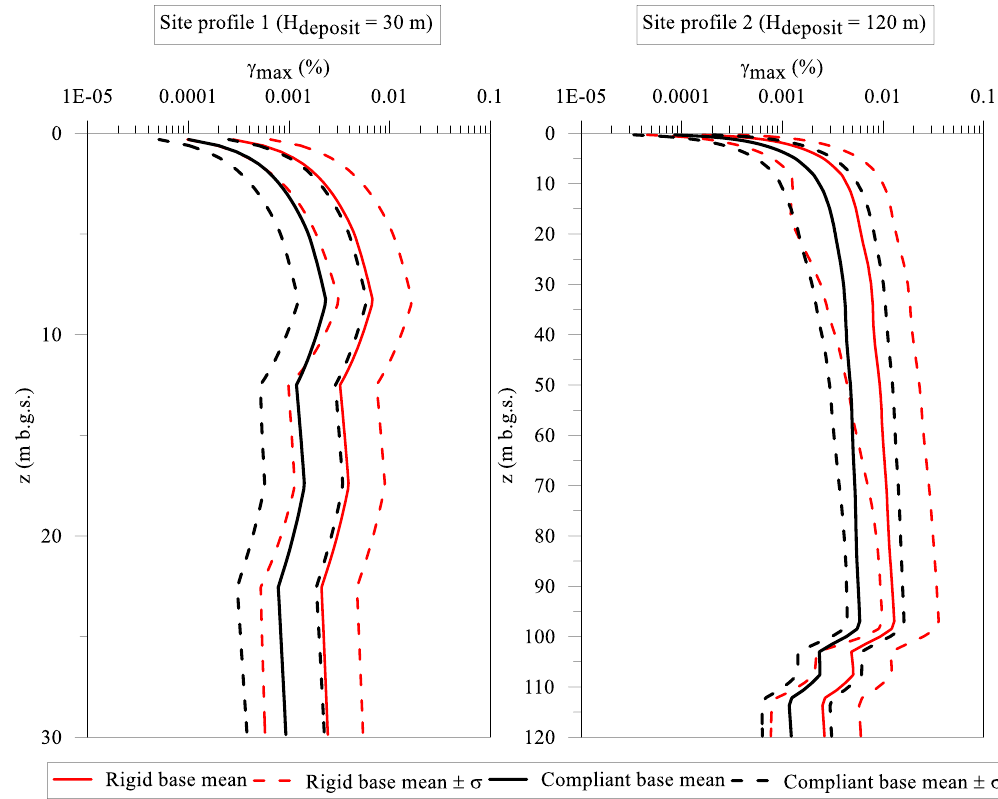
Figure 7. Distribution of ε AF referring to the heterogenous site profile 1 (H deposit = 30 m) and to the heterogenous site profile 2 (H deposit = 120 m).